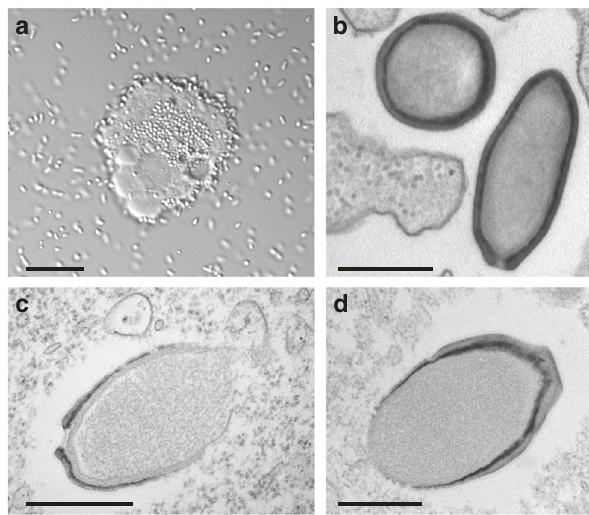
Fig. 1 The new pandoravirus isolates. a Overproduction by an A. castellanii cell of Pandoravirus macleodensis virions from the environmental sample prior cell lysis. Environmental bacteria can be seen in the culture medium together with P. macleodensis virions. (scale bar is 10 µ m). b TEM image of an ultrathin section of A. castellanii cell during the early phase of infection by P. neocaledonia . The ameba pseudopods are ready to engulf the surrounding virions. Ten minutes pi, virions have been engulfed and are in vacuoles (scale bar is 500 nm). c TEM image of an ultrathin section of A. castellanii cell during the assembly process of a P. salinus virion (scale bar is 500 nm). d TEM image of an ultrathin section of a nascent P. quercus virion. (scale bar is 500 nm). The structures of the mature particles from the different strains do not exhibit any noticeable